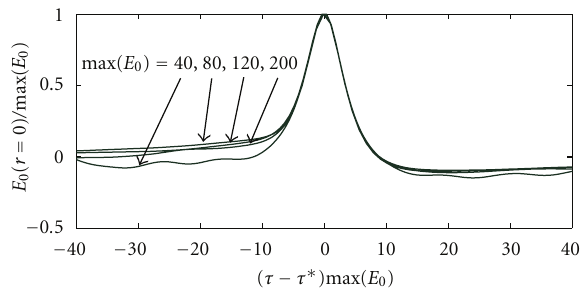
Figure 6: Scaled profiles of E 0 along the centerline η = ( Z − z ) − 2 / 3 r = 0, showing collapse onto a single self-similar profile. Similar results hold for η / =